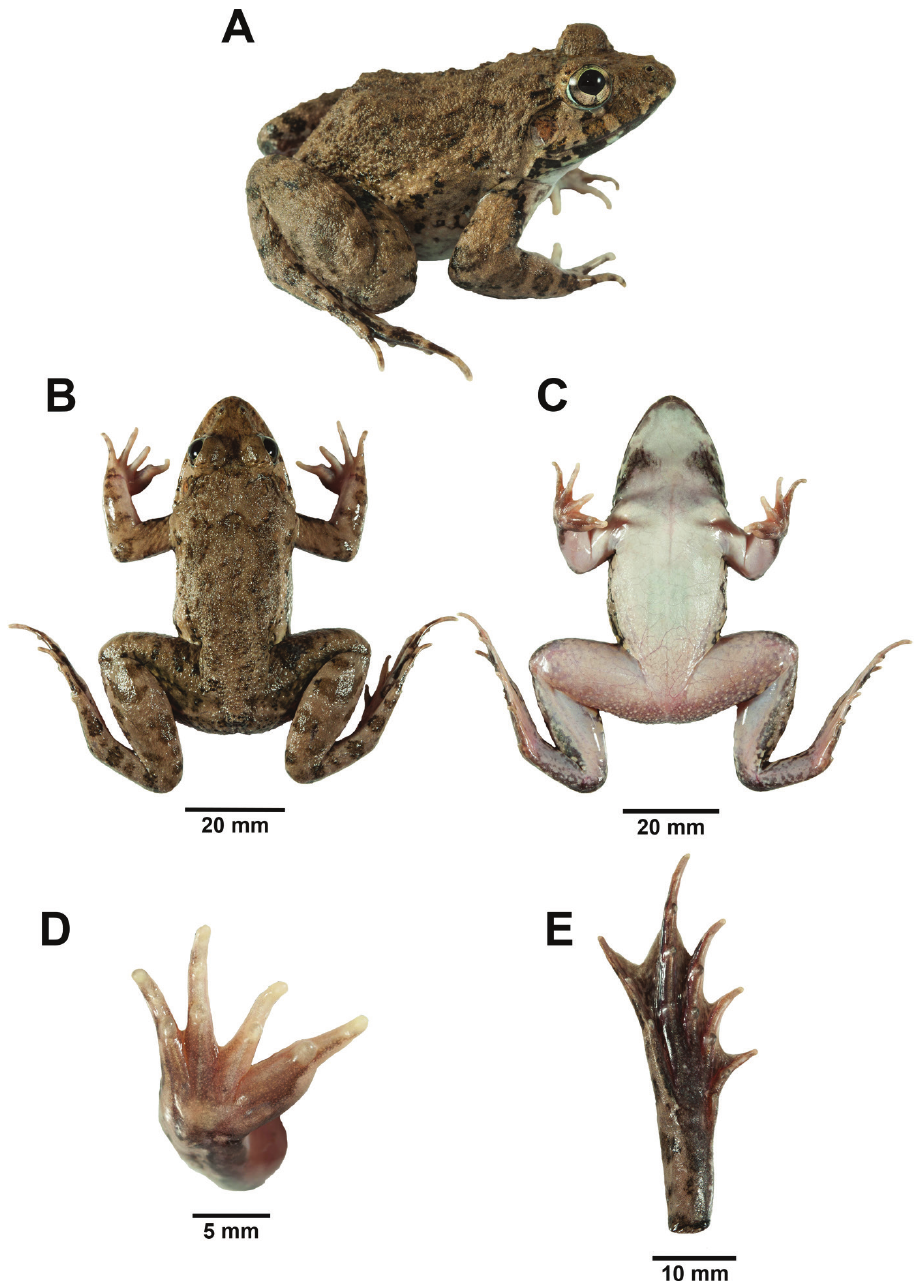
Figure 9. Adult male Fejervarya moodiei (ZMKU AM 01390) from Mueang Phang-nga District, Phang- nga Province, Thailand (SVL = 60.6 mm) immediately prior to preservation in A right lateral B dorsal C ventral D right palmar, and E right plantar views. Photographs by Attapol